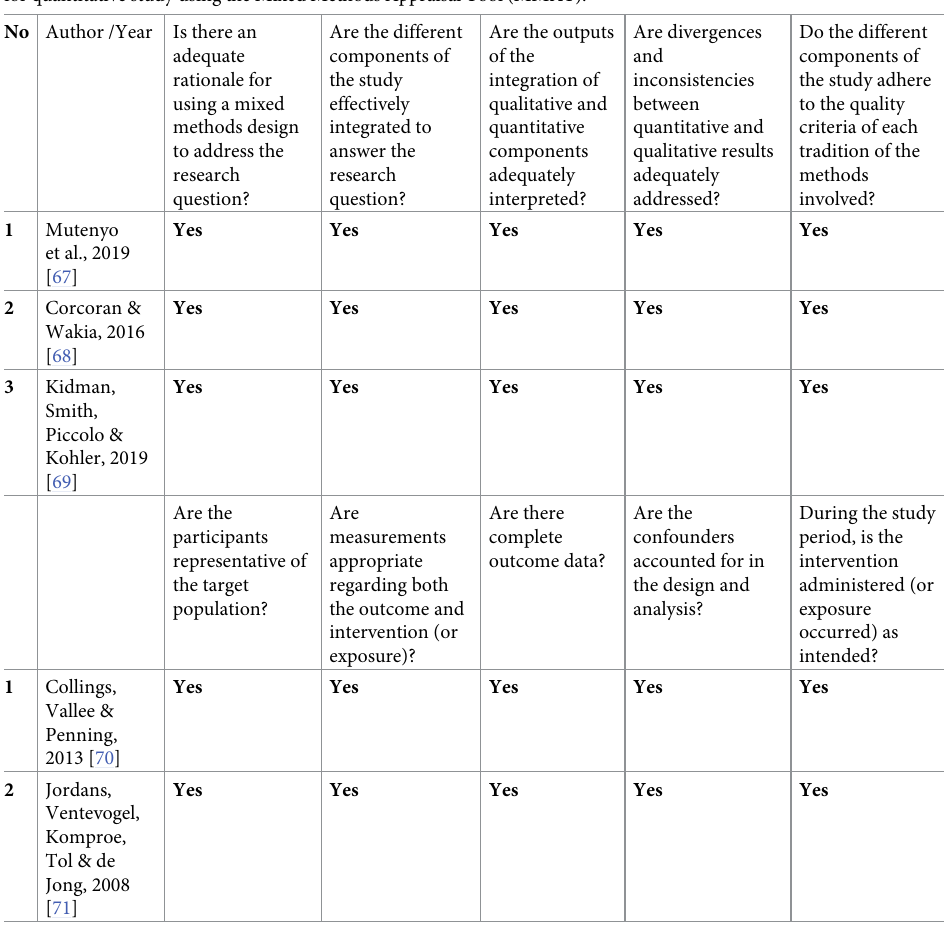
Table 4. A. A checklist for mixed method study using the Mixed Methods Appraisal Tool (MMAT). B. A checklist for quantitative study using the Mixed Methods Appraisal Tool